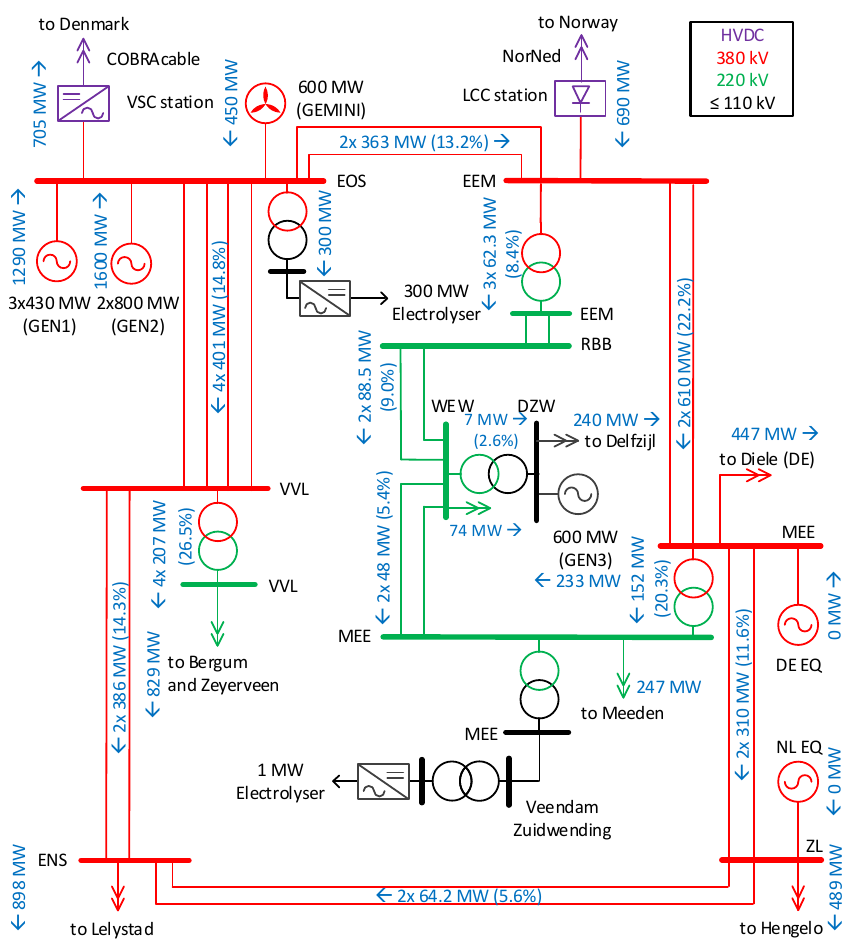
Figure 1. Example power flow profile of the N3 test system for year 2030